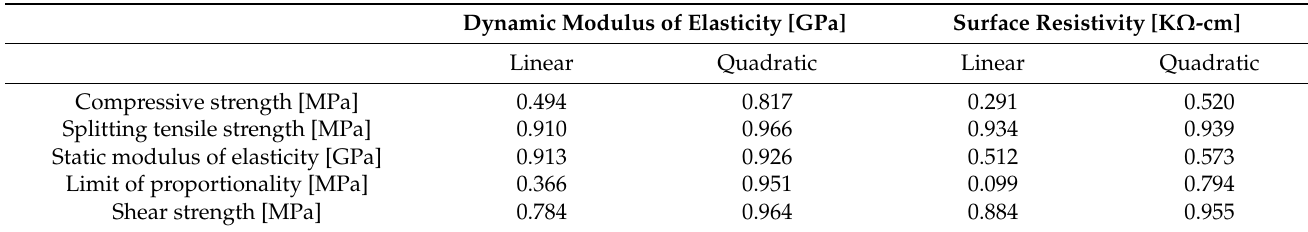
Table 3. Resulted values of coefficient of determination R 2 for all analysed pairs of parameters. Dynamic Modulus of Elasticity [GPa] Surface Resistivity [K Ω -cm]